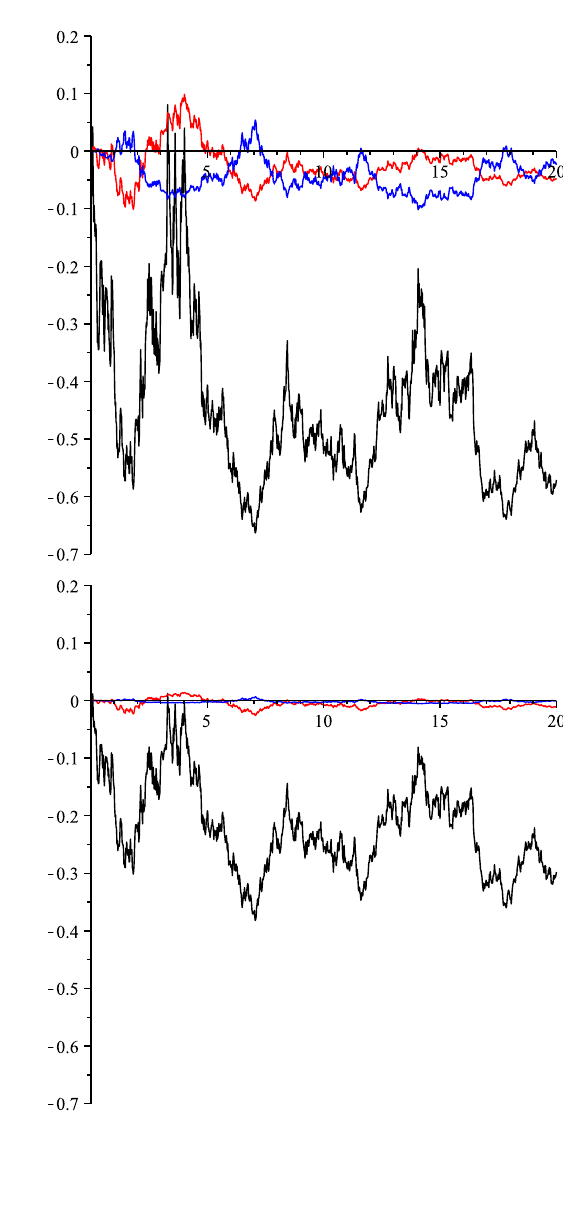
Figure 3. Relative difference of E [ X ( t )] (black), to X ( t ) for & = 1 ( top left ), & = 0 : 75 ( top right ), & = 0 : 5 ( bottom left ), & = 0 : 25 ( bottom right